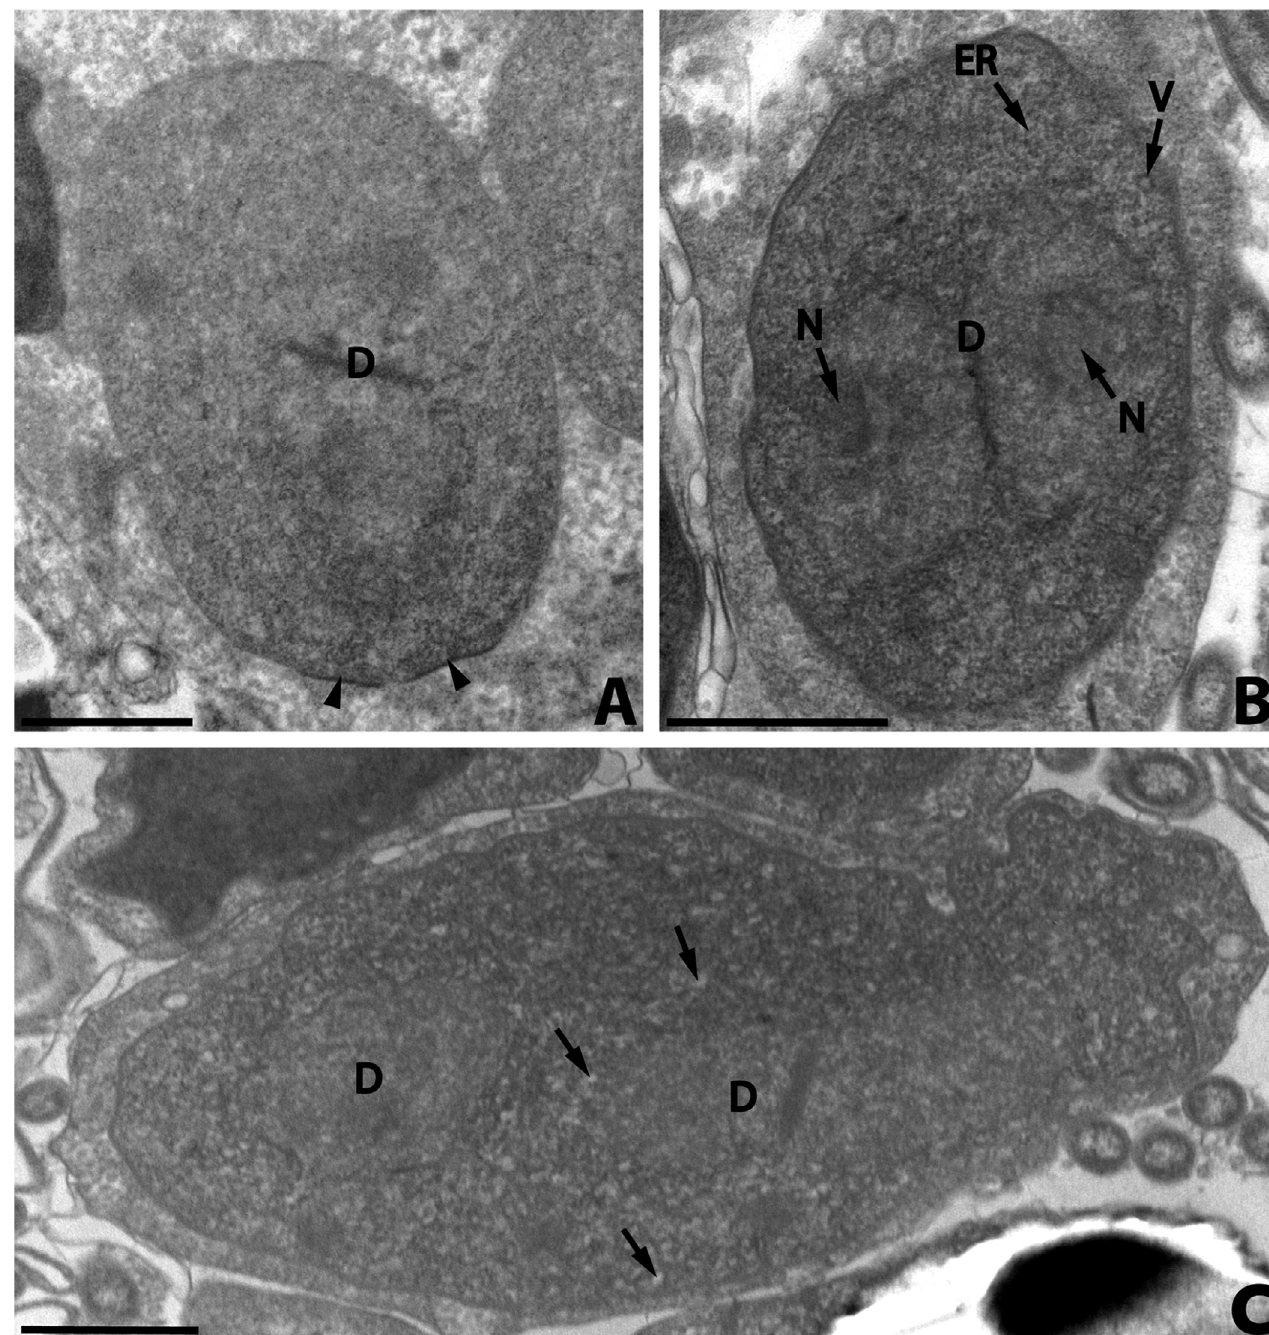
Figure 2. Nosema podocotyloidis n. sp. A. Young sporont showing the thickening of the wall (arrowheads). B. Sporont showing electron- lucent vesicles (V) and a few rough endoplasmic reticula (ER). C. Sporont with two diplokarya (D). Electron-lucent vesicles (arrows). D: diplokaryon; ER: endoplasmic reticulum; N: nucleolus-like formation; V: electron-lucent vesicles. Scale Bars: A, B, C and D, 1 l